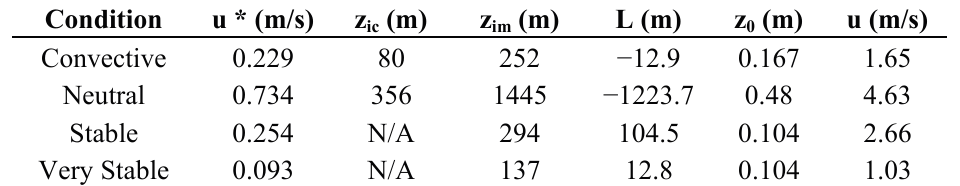
Table 6. Representative meteorological conditions from fall 2010 for Detroit, MI, USA. Condition u * (m/s)